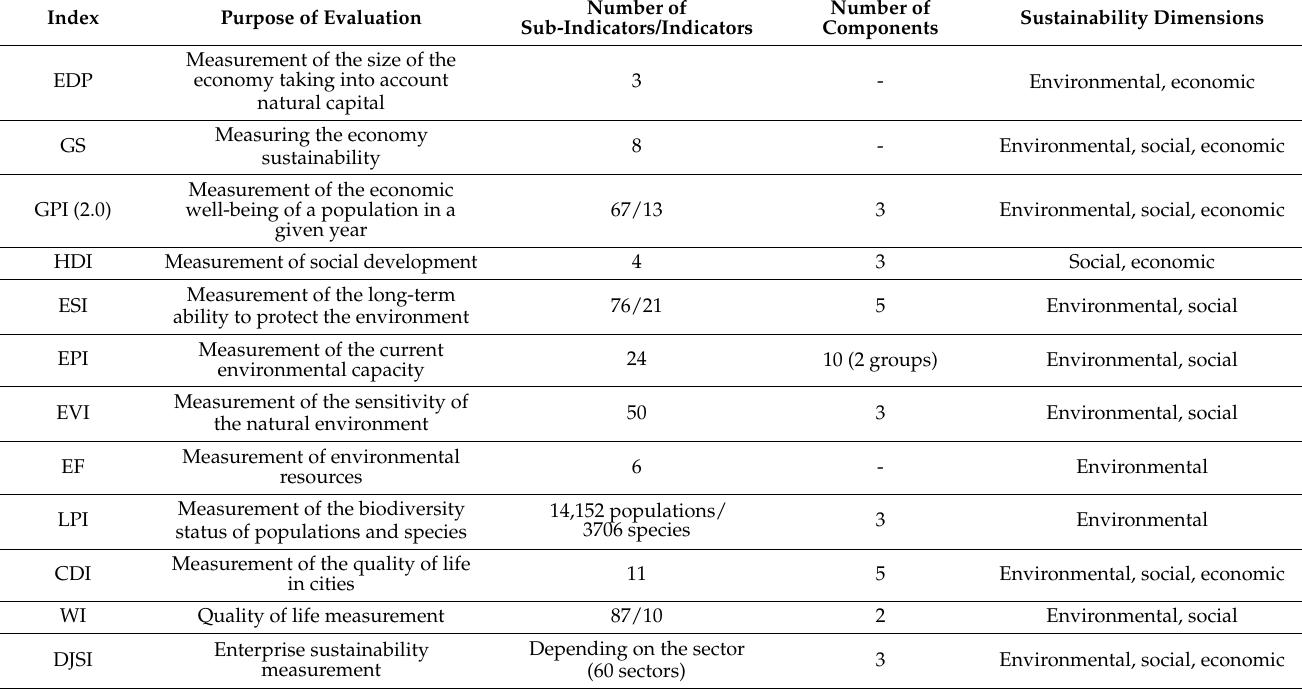
Table 2. Comparison of selected sustainability indices (part 1).